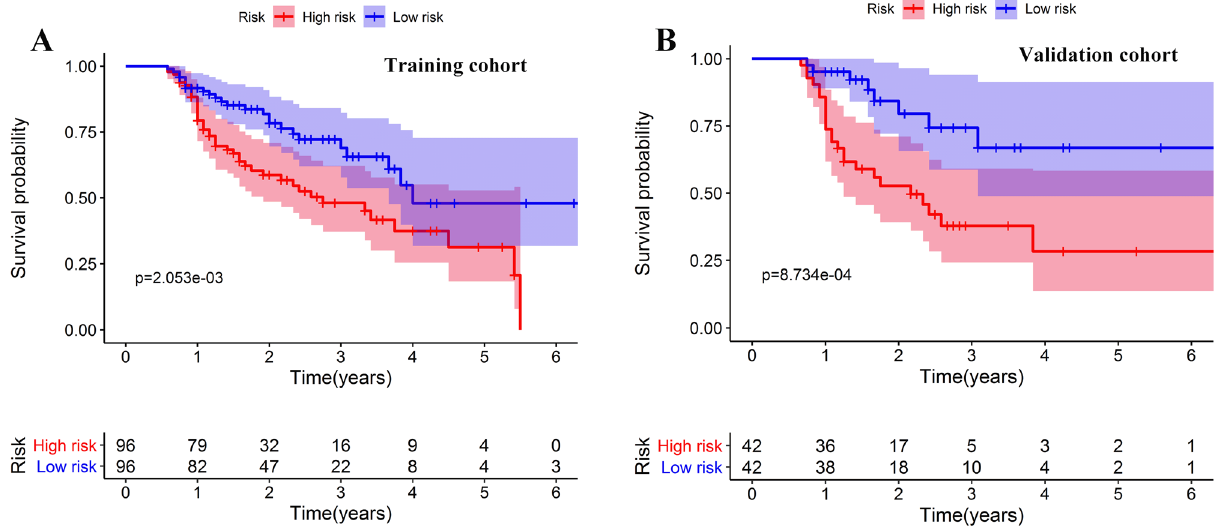
Figure 5. Kaplan–Meier curves of different risk groups stratified by the median value of riskscore calculated by the nomogram in the training (A) and validation (B) cohorts. The figure was performed using R software (version 3.3.1, Vienna, Austria, https:// www.r- proje ct. org/).